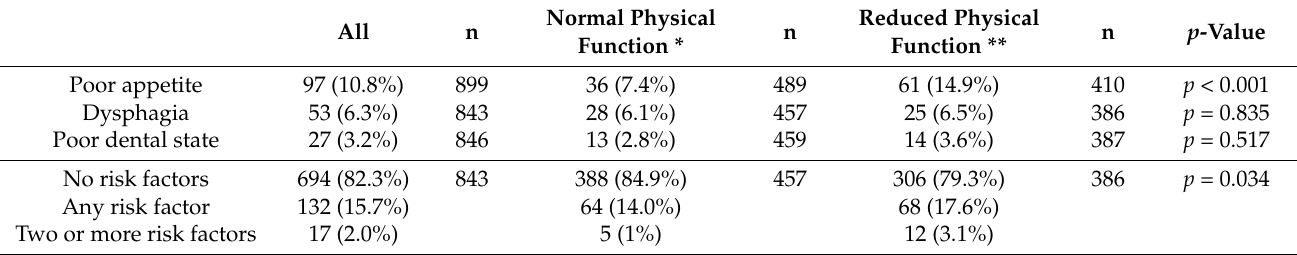
Table 2. Prevalence and combination of malnutrition risk factors.